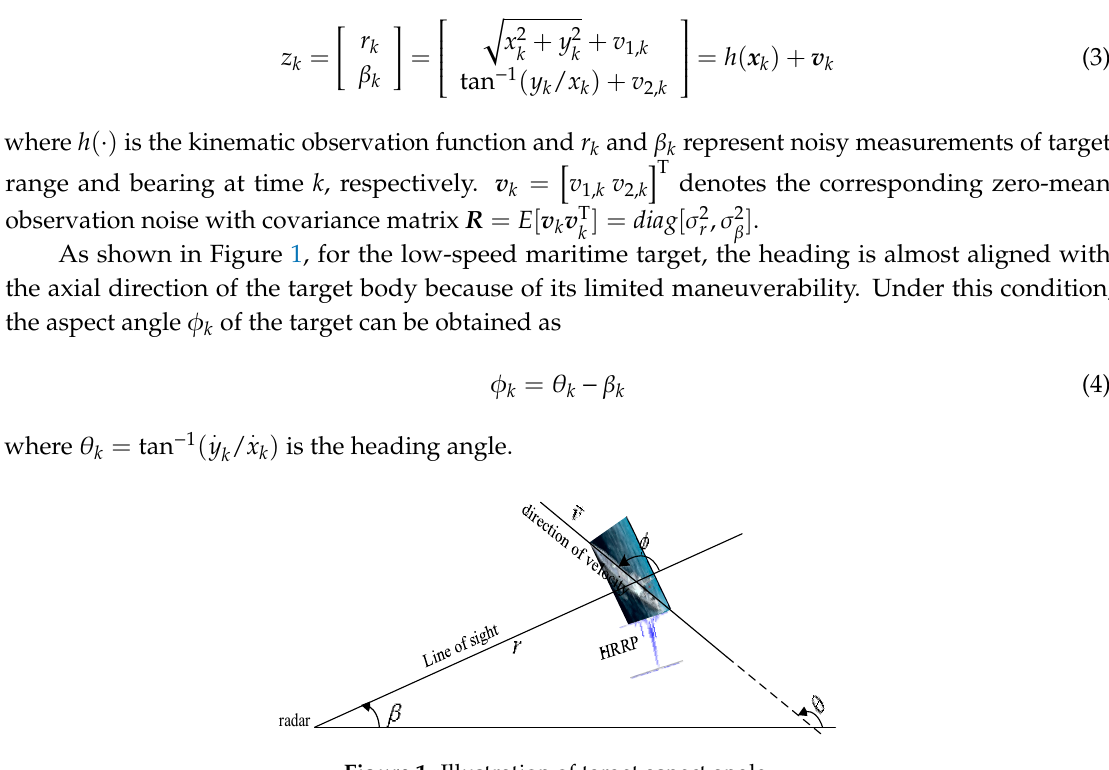
Figure 1. Illustration of target aspect angle.